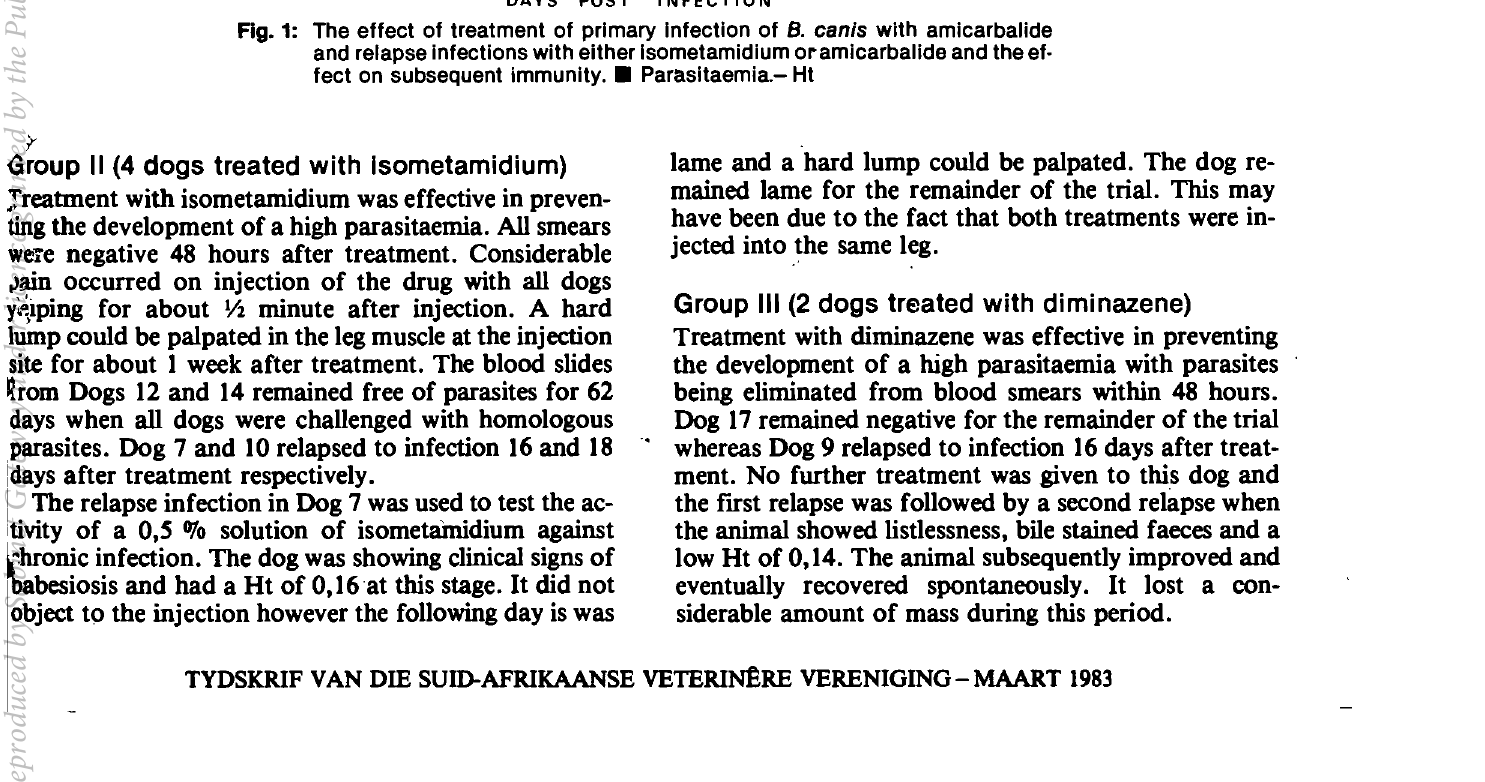
Fig. 1: The effect of treatment of primary Infection of B. canis with amicarbalide and relapse infections with either Isometamidium oramicarbalide and the ef· feet on subsequent immunity .• Parasitaemla.-